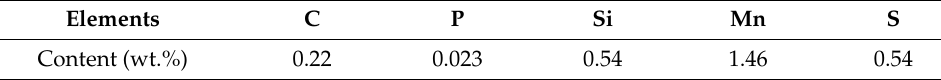
Table 1. The chemical composition of 600 MPa steel (wt.%).